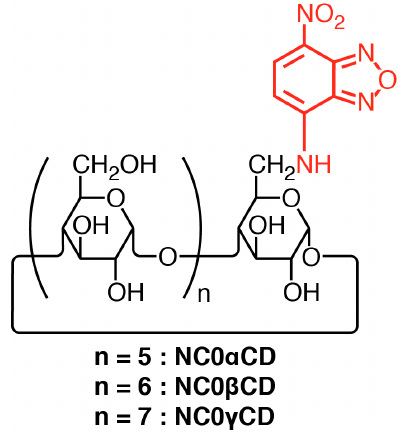
Figure 2. Structures of NBDamine-modified cyclodextrins.